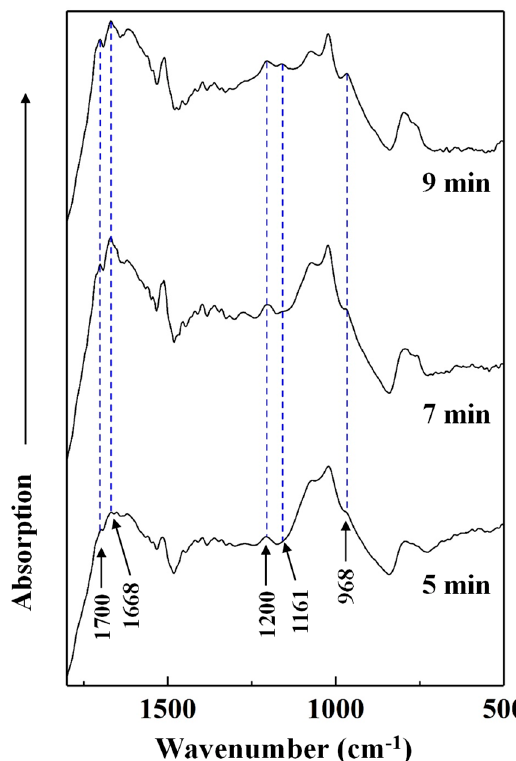
Figure 8. FT-IR spectra of insoluble mass derived from SADP adhesive heated for different time.